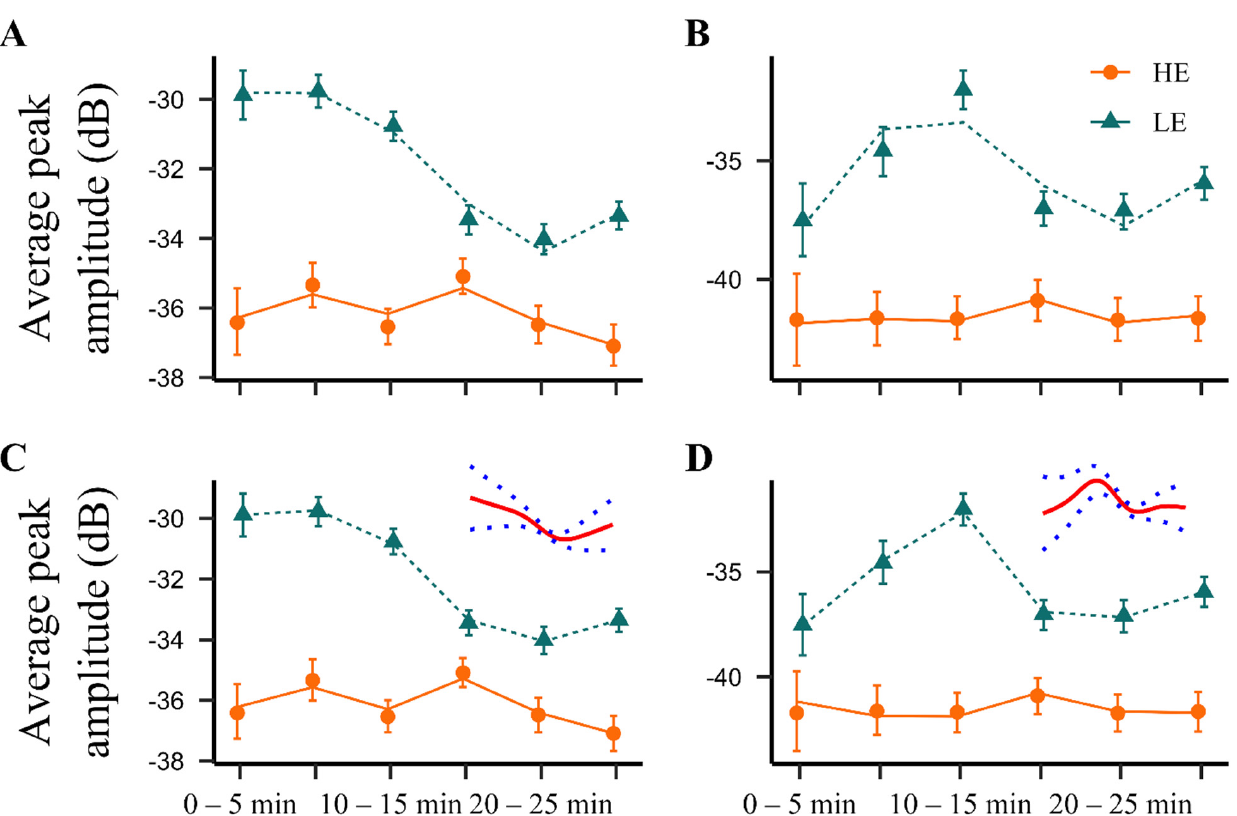
Figure 5. Average peak amplitude of NPS-induced (1 nmol, i.c.v.) 22 kHz calls. Symbols: Observed time-binned average peak amplitudes of long ( A , C ) and short ( B , D ) 22 kHz USVs (error bars indicate 95% confidence limits for the population mean obtained by nonparametric bootstrap). Lines: Model-based predictions from LMM ( A , B ) and GAM ( C , D ; difference in splines added). HE: high exploring rats; LE: low exploring rats; NPS: neuropeptide S. HE NPS ( n = 9); LE NPS ( n = 10). Please note that average peak amplitude (acoustic intensity measured in decibels (dB)) is a negative value, and a less negative value reflects a louder vocalization [50].